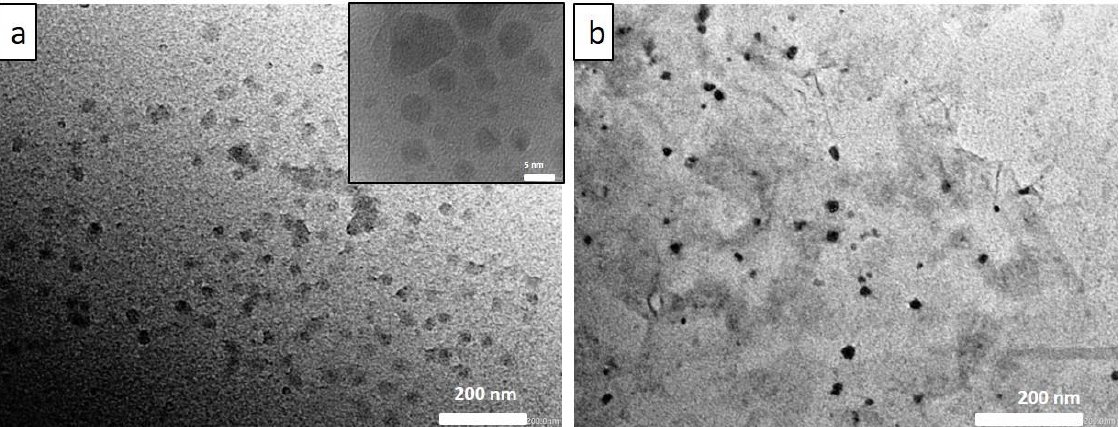
Figure 1. The representative HRTEM images of CDs at different scales ( a ) and CDs absorbed on GO surface ( b ).